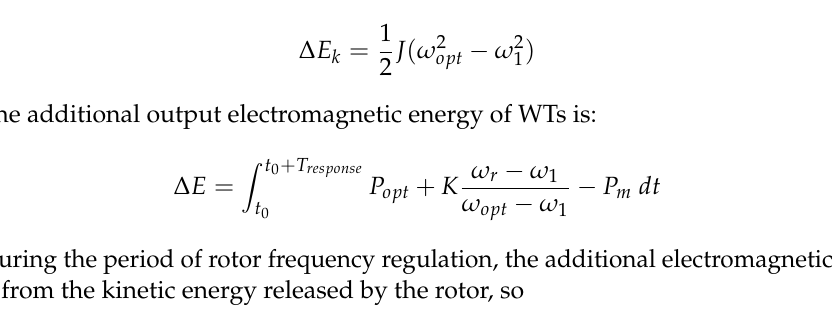
Figure 3. Block diagram of improved frequency control strategy of DFIG.